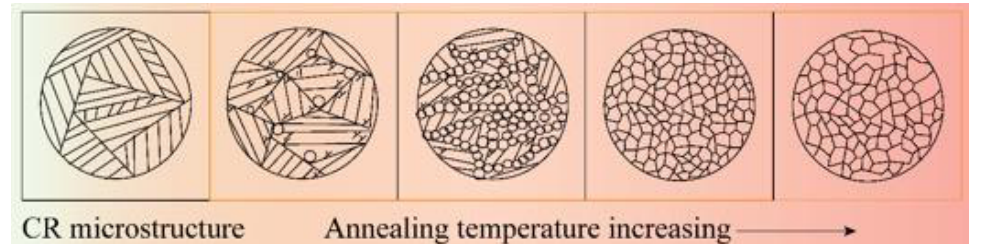
Figure 9. The illustration of the CR microstructural evolution of Fe – 19Mn – 0.6C TWIP steel as the annealing temperature increases.